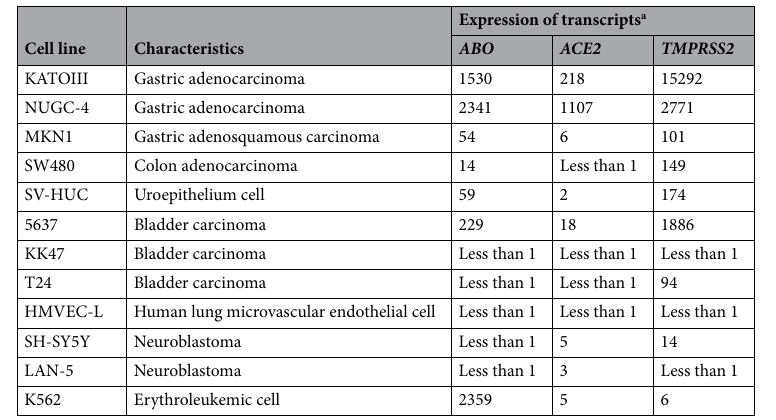
Table 1. Expression levels of ABO , ACE2 and TMPRESS2 in various cultured cell lines. a Expression levels are presented as means of duplicate determinations for copy numbers of target transcript per 10 4 copy numbers of ACTB transcript.